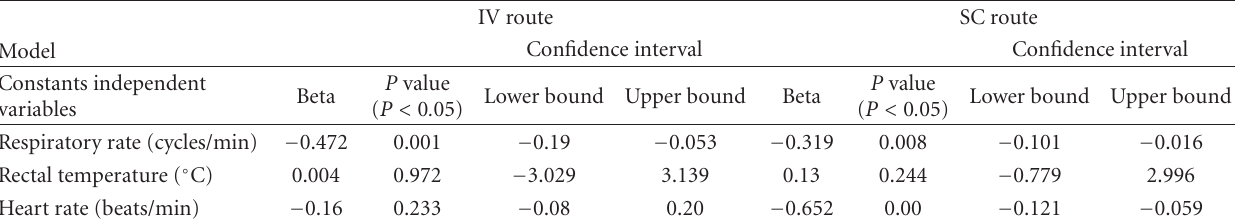
Table 2: The relationship between the subjective parameters and mechanical pain threshold was assessed using multiple linear regression.